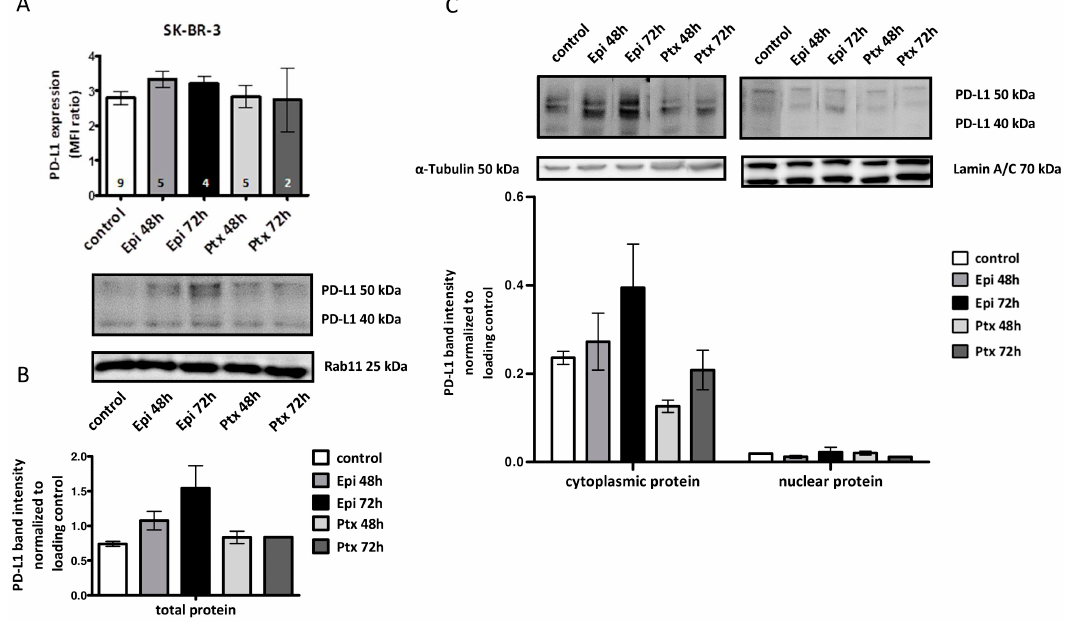
Figure 4. PD-L1 cell surface, total protein, and fractioned protein expression after cytotoxic treatment in SK-BR-3 BC cell line. ( A ) Flow cytometric measurement of PD-L1 expression on SK-BR-3 BC cell line after cytotoxic treatment with Epi and Ptx. Data are represented as MFI ratio = (MFI PD-L1 /MFI isotype ) ± SEM. Number of experiments are indicated in each bar; ( B ) Western blot analysis of SK-BR-3 total protein lysates after cytotoxic treatment. Rab11 was used as loading control. Data are presented as mean ± SEM ( n = 2); ( C ) Western blot analysis of PD-L1 protein expression in cytoplasmic and nuclear fraction after cytotoxic treatment of SK-BR-3 BC cell line. Lamin A/C was used as a loading control for nuclear protein, and α -Tubulin for the cytoplasmic protein fraction. Data are presented as mean ± SEM ( n = 2). Representative western blots are provided for each dataset.